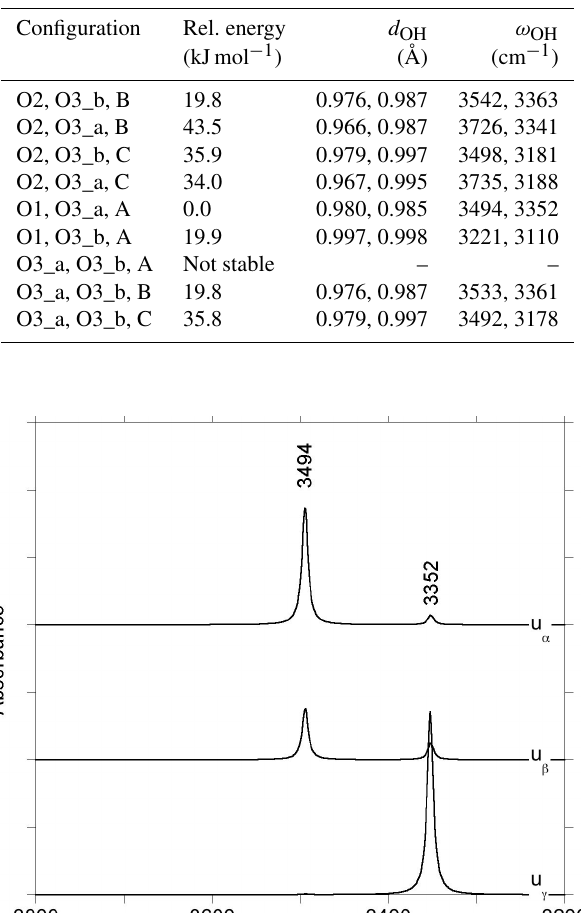
Table B1. Properties of [(2H + ) Si (Ti 4 + ) M1 ] × defects.